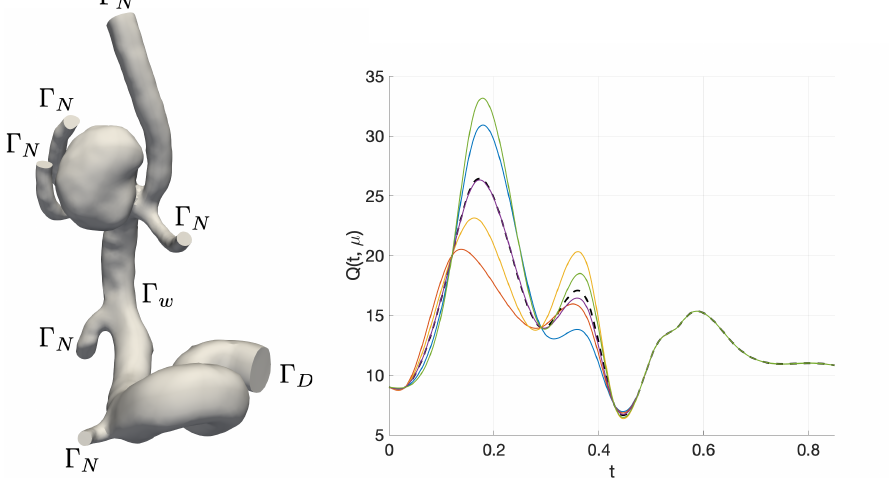
Figure 12. Test case 3 . Aneurysm geometry ( left ) and inlet flow rate Q ( t ; µ ) during the heart cycle for different parameter values ( right ); the black dashed curve corresponds to the base profile Q ( t )